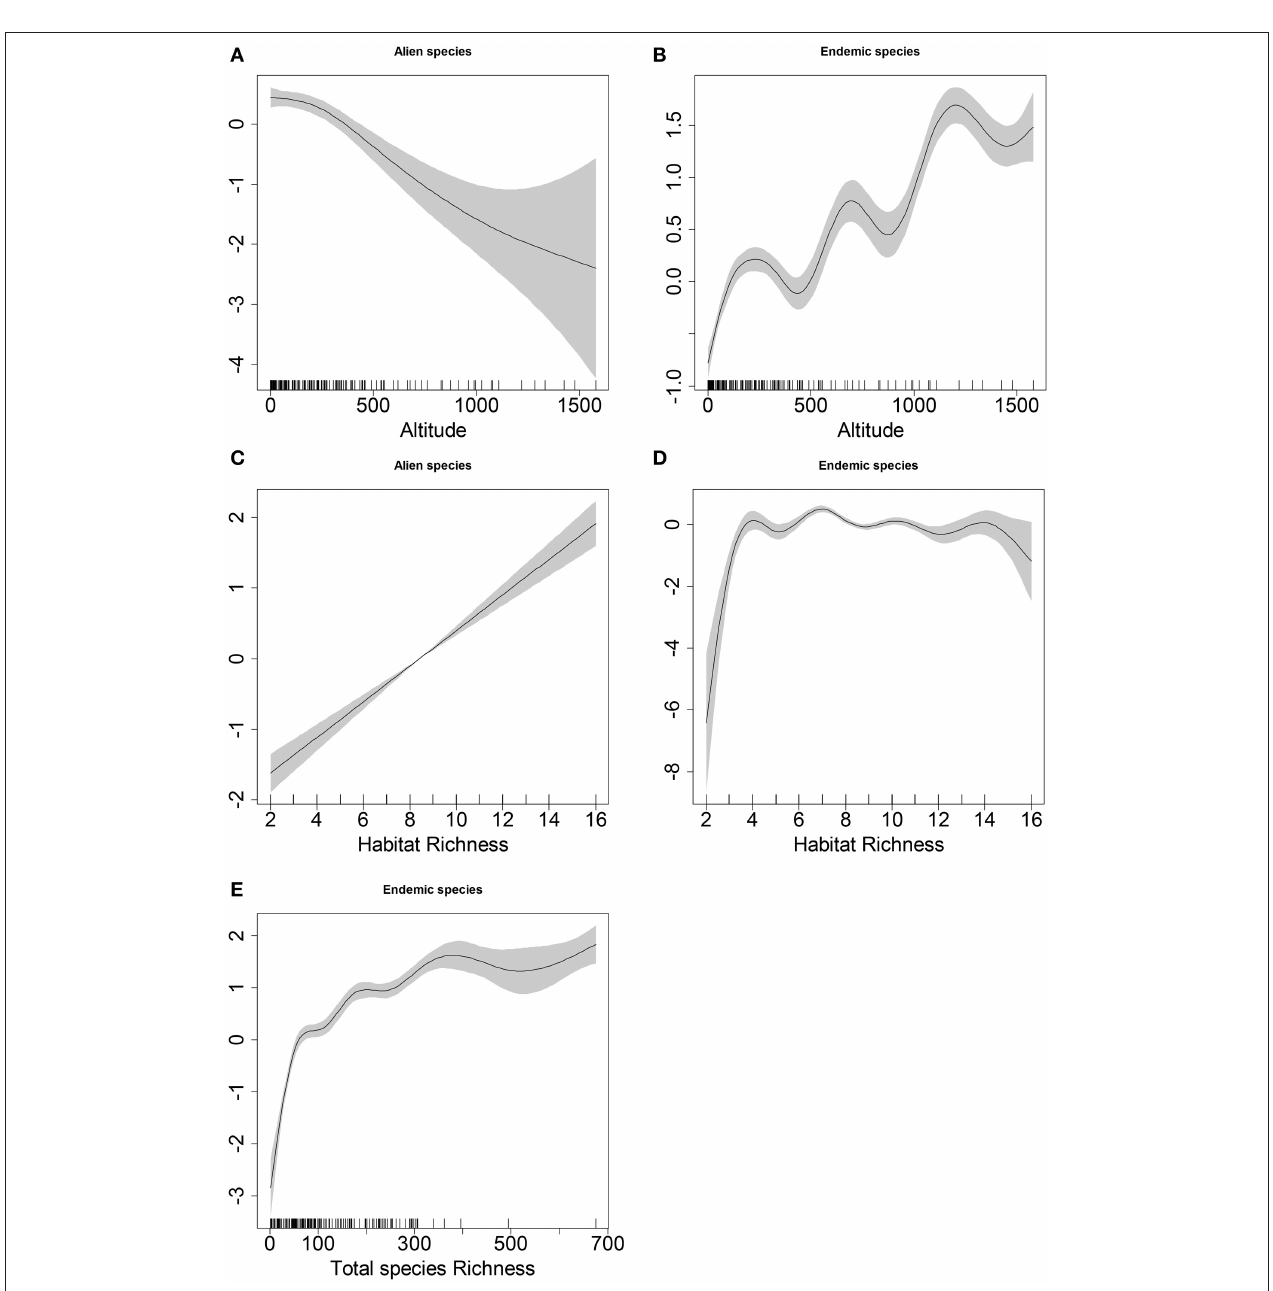
FIGURE 4 | Estimated smooth terms for (A) alien species richness and altitude, (B) endemic species richness and altitude, (C) alien species richness and habitat richness, (D) endemic species richness and habitat richness, and (E) endemic species richness and native species richness. Smooth terms (black lines) are given in the linear predictor scale and the corresponding 95% confidence intervals are indicated with gray intervals. The numbers after the commas in the y-axis titles are the estimated degrees of freedom of the smooth terms. Rug on the horizontal axis represents density of datapoints.